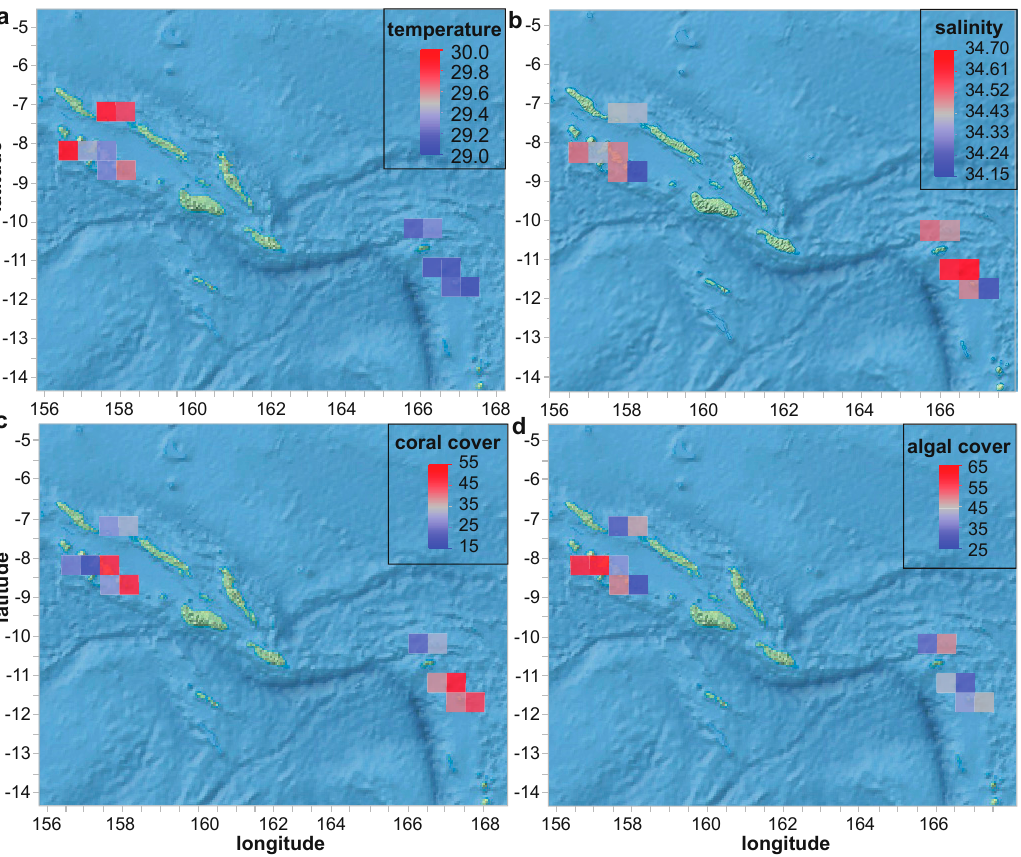
Figure 3. Spatial variation in seawater quality ( a , b ) and general benthic parameters ( c , d ). Values in ( c , d ) represent percentages (%) of total benthos.